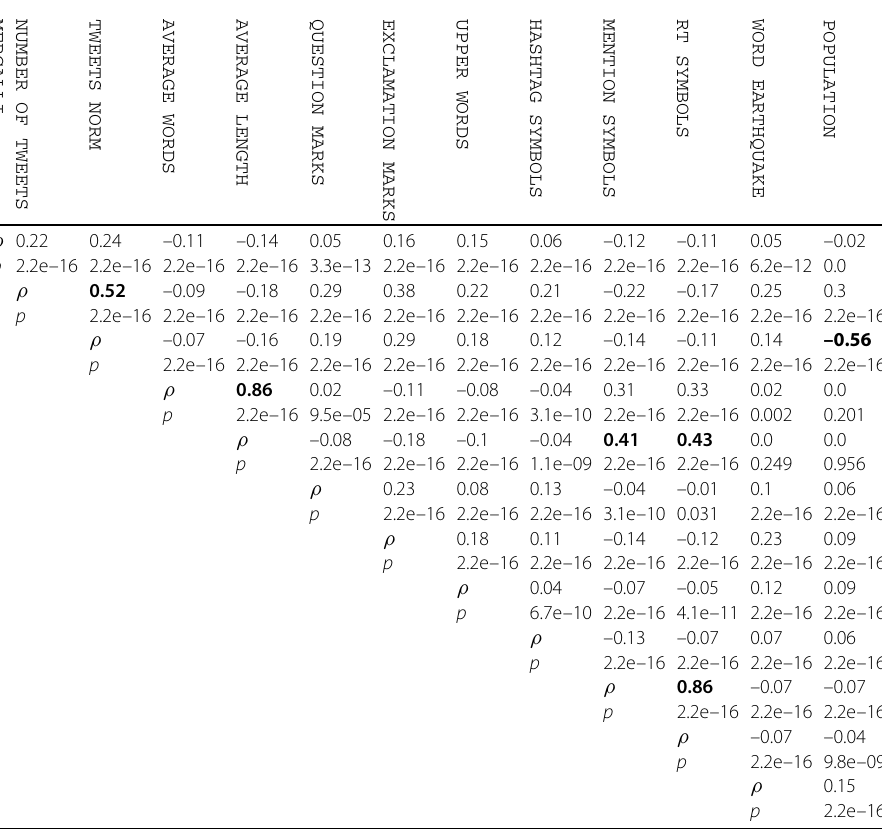
Table 3 Spearman correlation coefficient for the features considered in our study. As expected, the correlation between NUMBER OF TWEETS and TWEETS NORM is strong, as well as that between AVERAGE WORDS and AVERAGE LENGHT , and between MENTION SYMBOLS and RT SYMBOLS . The Spearman coefficients found are statistically significant, as the p -values show. Strong correlations are indicated with bold fonts